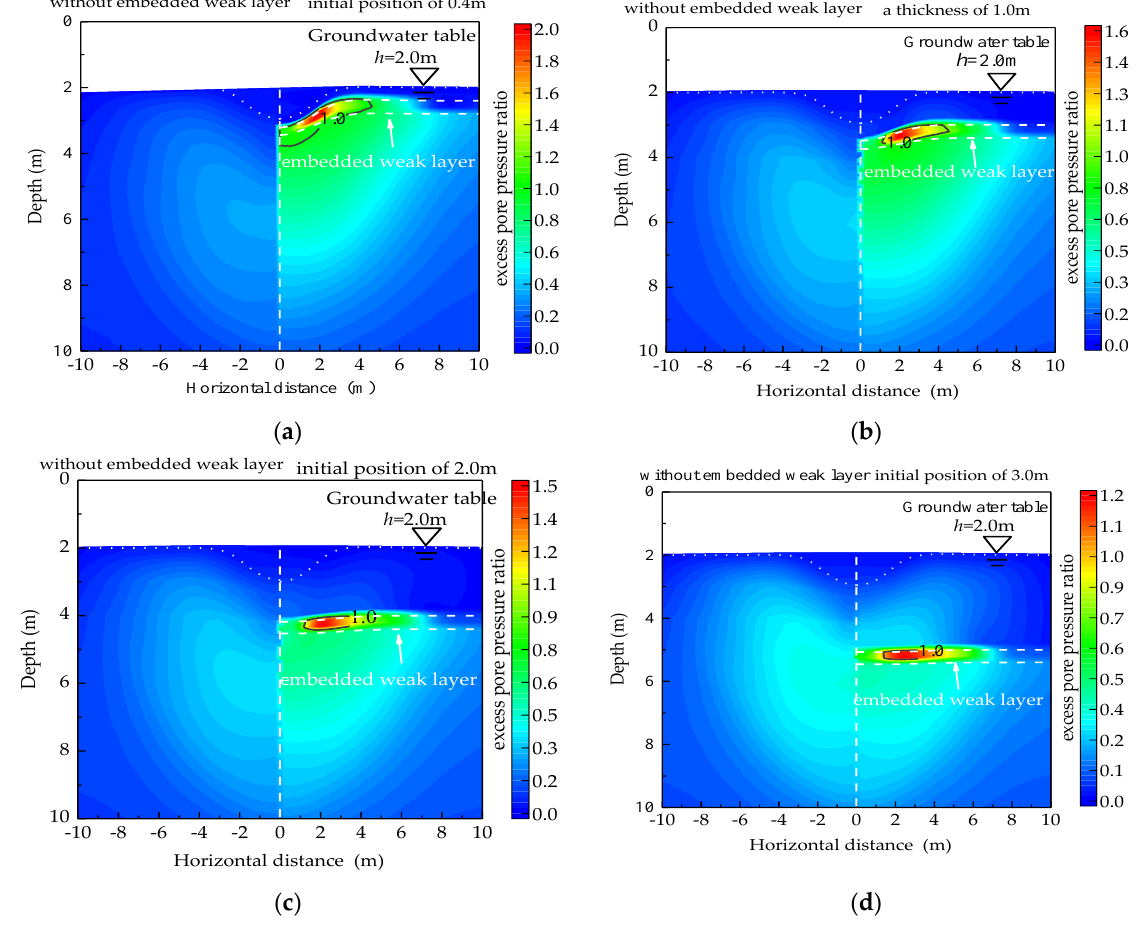
Figure 15. Distributions of excess pore water pressure ratio in grounds with weak interlayer of different initial position. ( a ) 0.4 m; ( b ) 1 m; ( c ) 2.0 m; ( d ) 3.0 m.